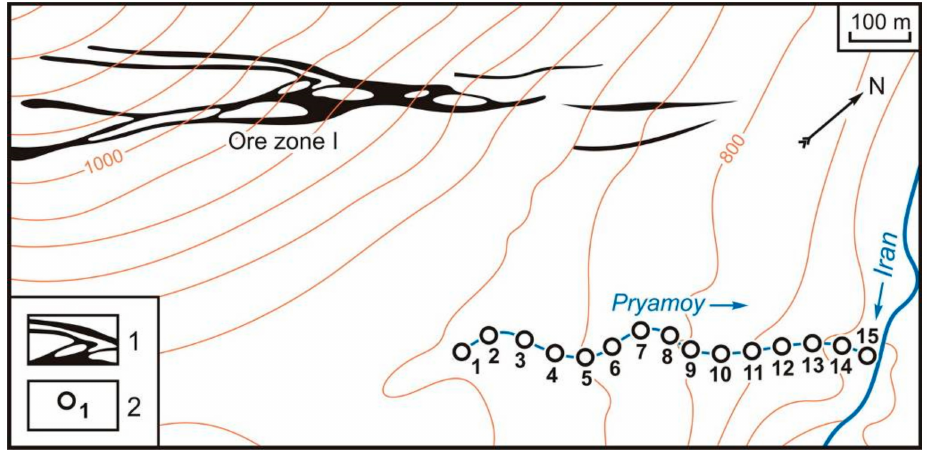
Figure 11. The Goltsovy Ag – Pb deposit (fragment). The scheme of bryolithochemical and lithochemical sampling of the I-order watercourse (Pryamoy stream). 1—ore bodies, 2—sampling points and their numbers.